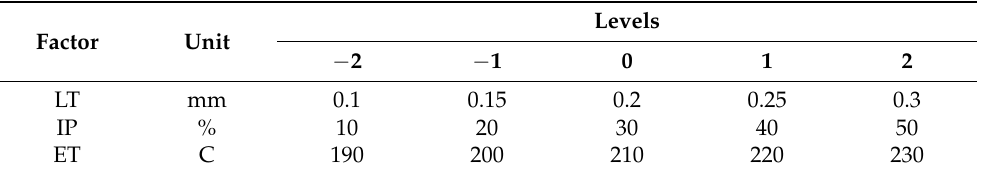
Table 1. Experimental data for the levels of independent factors.